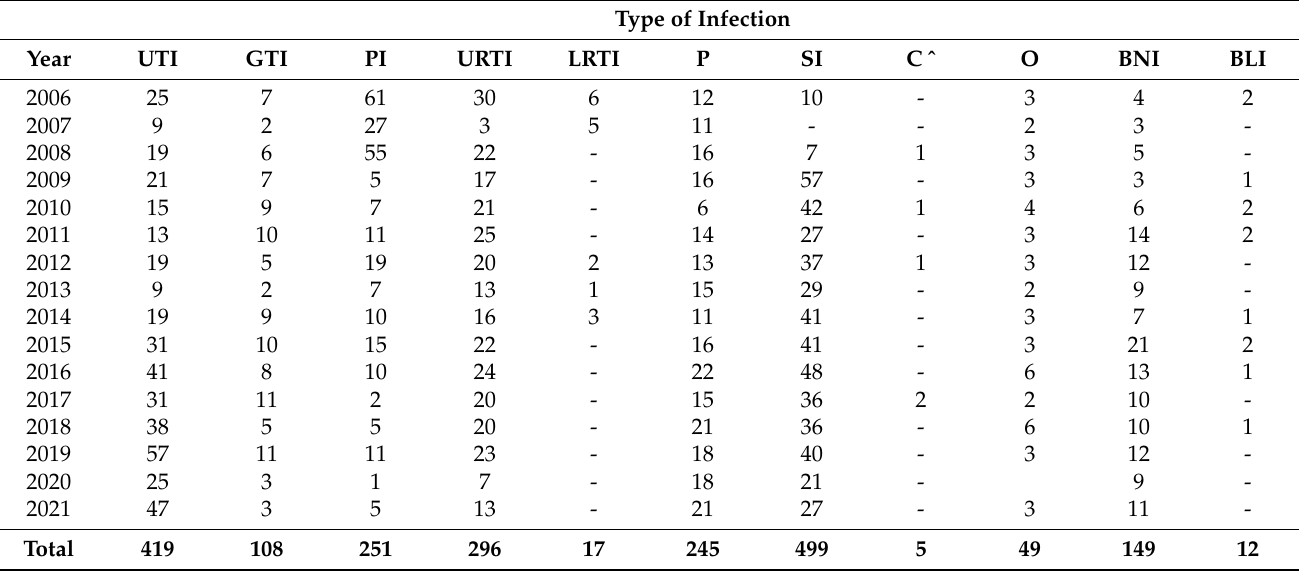
Table 2. Type of infection in patients registered at the PTU in the years 2006–2021 * (source: internal documentation).